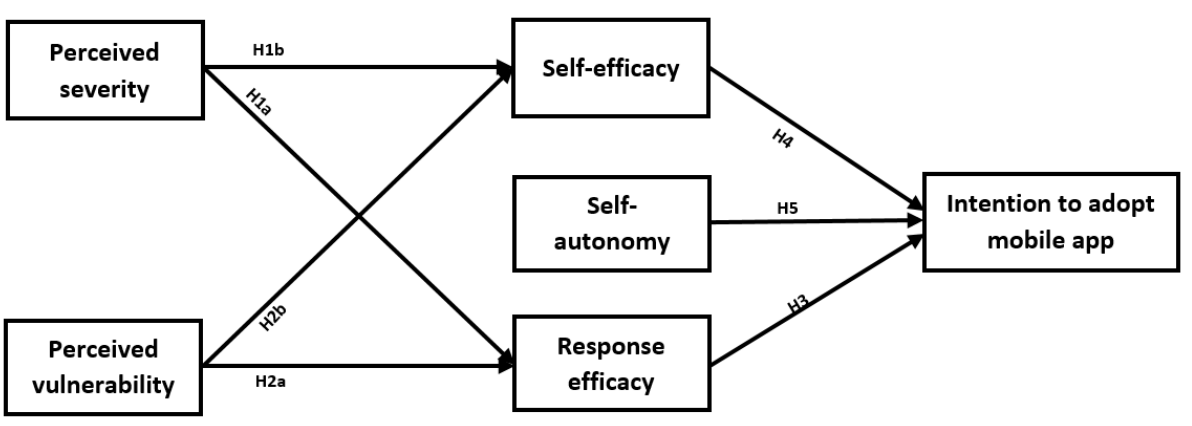
Figure 2. Research